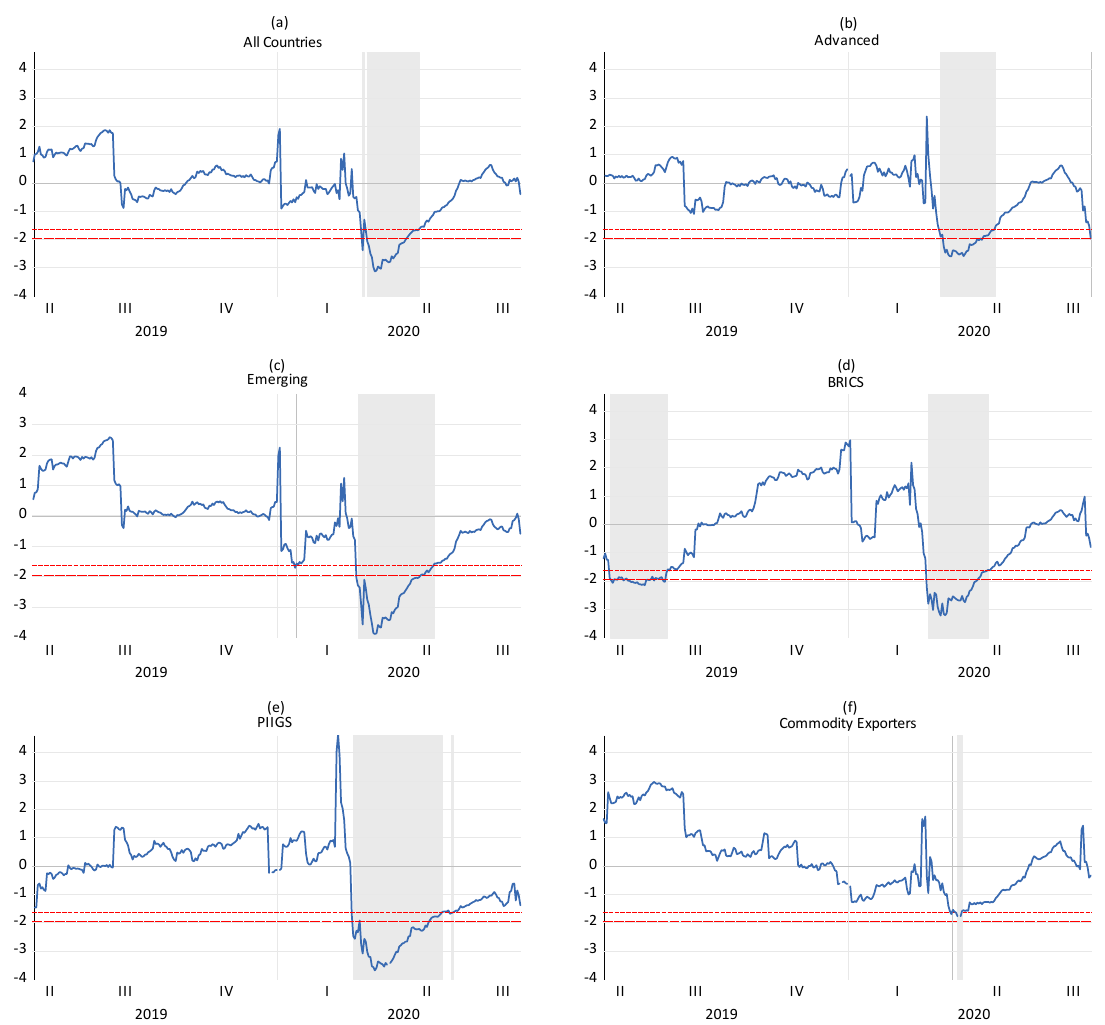
Figure 2. Rolling-window herding coefficients (source: based on the authors’ own estimation of Equation (2)). Note: the horizontal lines with short dashes represent a 10% significance level, while the long-dashed lines represent a 5% significance level along with the shaded areas associated D 1 and D 2 dummy variables. As D 2 is corresponds to higher significance level, it overlaps with D 1 .